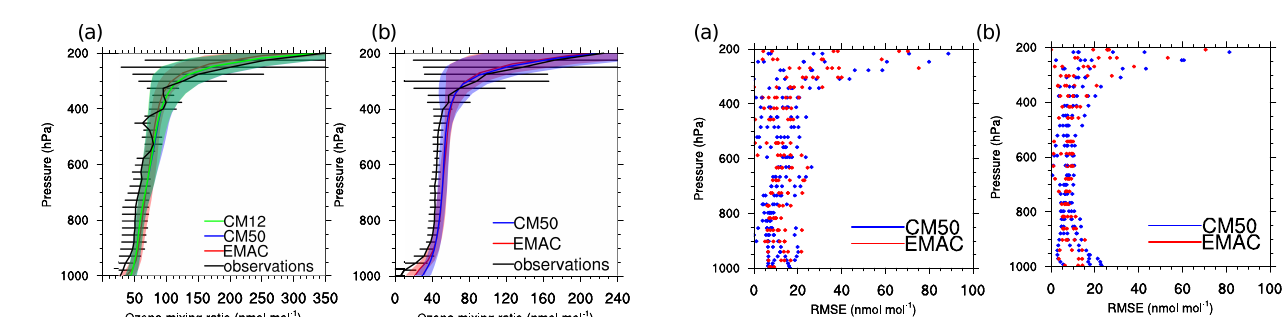
Figure 13. Vertical ozone profile (in nmolmol − 1 ) at De Bilt (Netherlands) for (a) June, (b) December 2008. In (a) results for all EMAC and the two COSMO/MESSy instances are shown, while (b) shows the results for EMAC and CM50. The standard deviation of the temporal mean is indicated by the error bars for the observa- tions and by the shaded area for the simulation data.